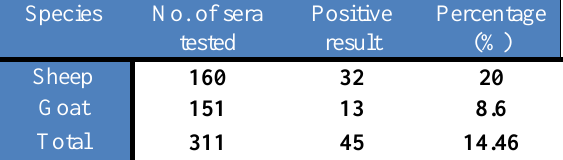
Table, 3: Percentage of sheep and goat brucellosis by using mRBT according to animal species.